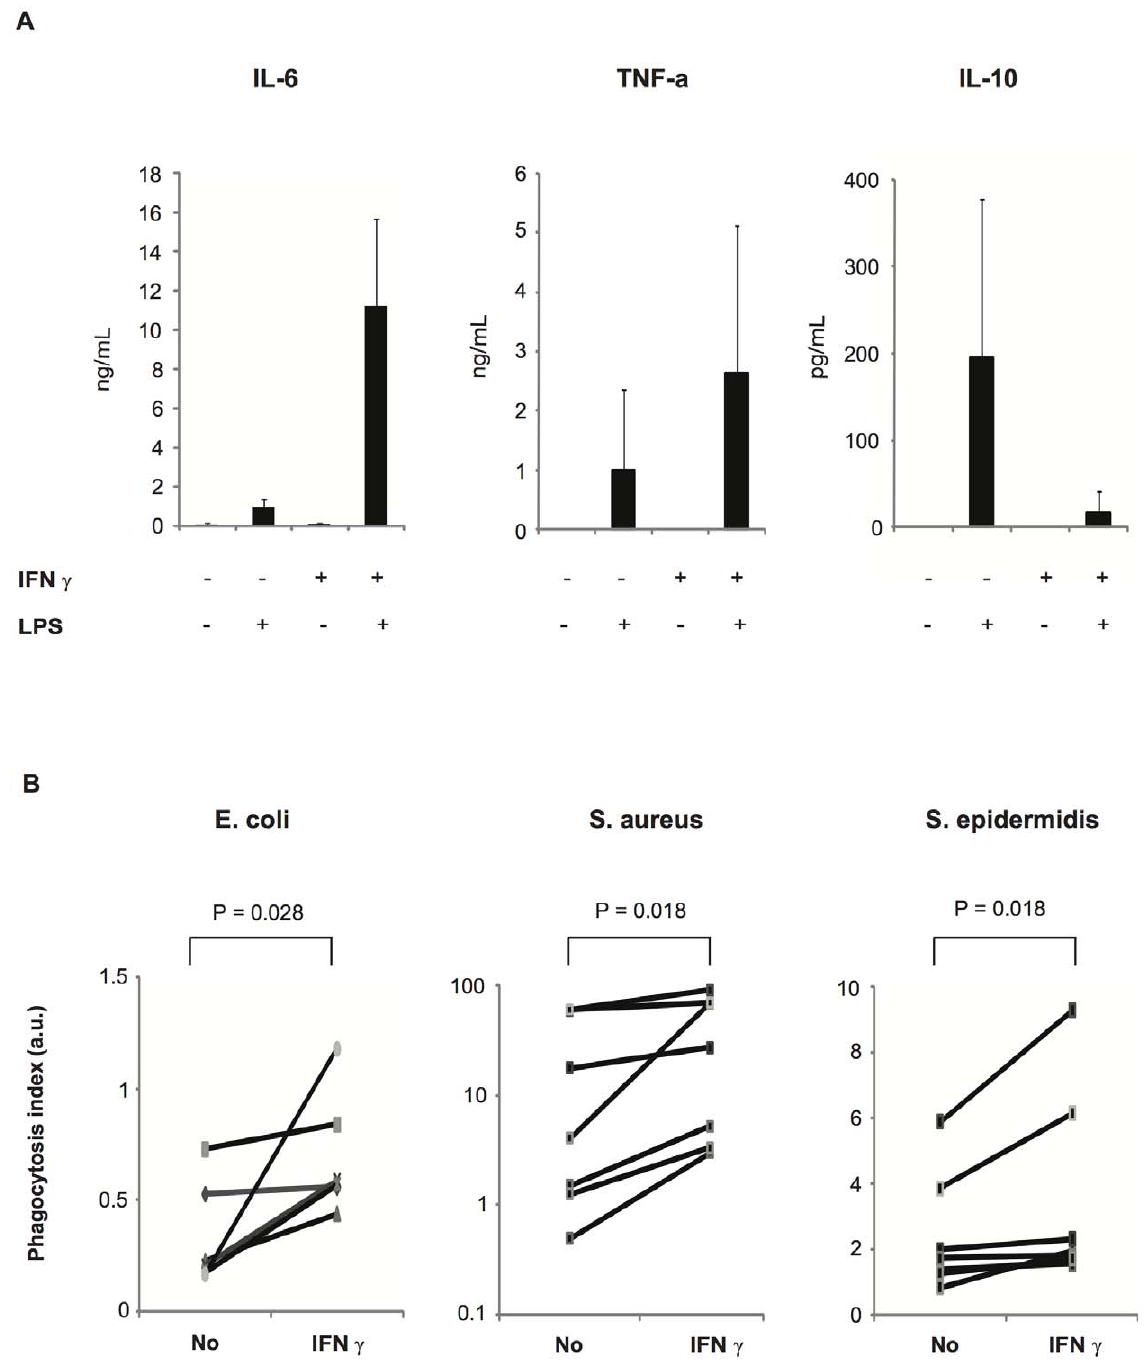
Figure 4. LPS responsiveness of leukocytes and opsonic capacity of plasma from premature infants with and without the addition of interferon- c . (A) Whole blood from 7 extremely premature infants (born before 28 wks of gestational age) was treated ex vivo or not for 12 hrs with interferon (IFN)- c . LPS was then added for an additional 12 hrs and IL-6, TNF- a , and IL-10 were measured (mean 6 SEM) in conditioned plasma. (B) The plasma from whole blood obtained in seven extremely premature infants (born before 28 wks of gestational age) treated ex vivo or not with for 12 hrs with IFN- c was incubated with fluorescent E.coli , S.aureus and S.epidermidis (opsonisation). Opsonised bacteria were then incubated with neutrophil-like HL-60 cells for 40 min; intracellular fluorescence was measured by flow cytometry, and expressed as mean phagocytic index ( 6 SEM). Statistical significance was tested with Wilcoxon matched-pairs signed rank test. doi:10.1371/journal.pone.0032863.g004 bacterial products displayed at the surface of phagocytes from controls. This phenomenon was also observed by others and premature infants. In contrast, term newborns displayed a robust may be related to the lack of a proper counter-regulation by the pro-inflammatory response, even greater than that of adult anti-inflammatory cytokine IL-10, and/or to a leukocyte priming